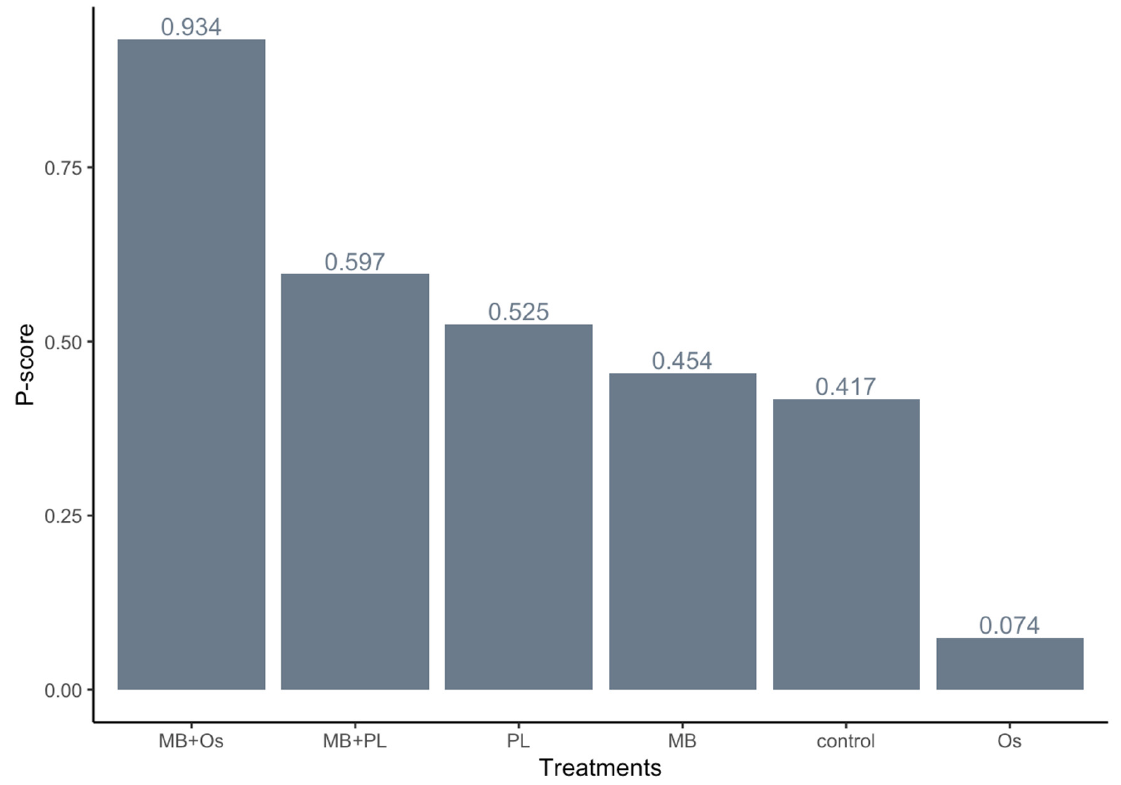
Figure 6. Ranking of GTR techniques by P-score.